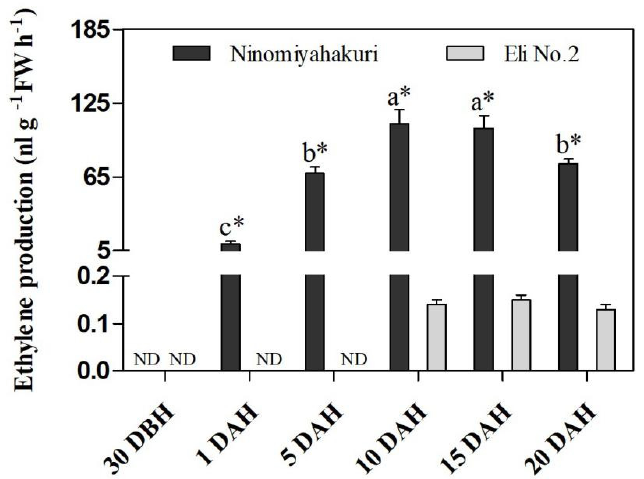
Figure 7. The ethylene production of fruits in ripening period of ‘Ninomiyahakuri’ and ‘Eli No. 2’ fruits. DBH: day before harvest. DAH: day after harvest. ND: None detected. ‘*’ in each graph indicates a significant difference between ‘Ninomiyahakuri’ and ‘Eli No. 2’ cultivar ( t -test, n = 3, p < 0.05). Different lower-case letters indicate significant differences among time points in the same cultivar (Duncan-test, n = 3, p < 0.05).